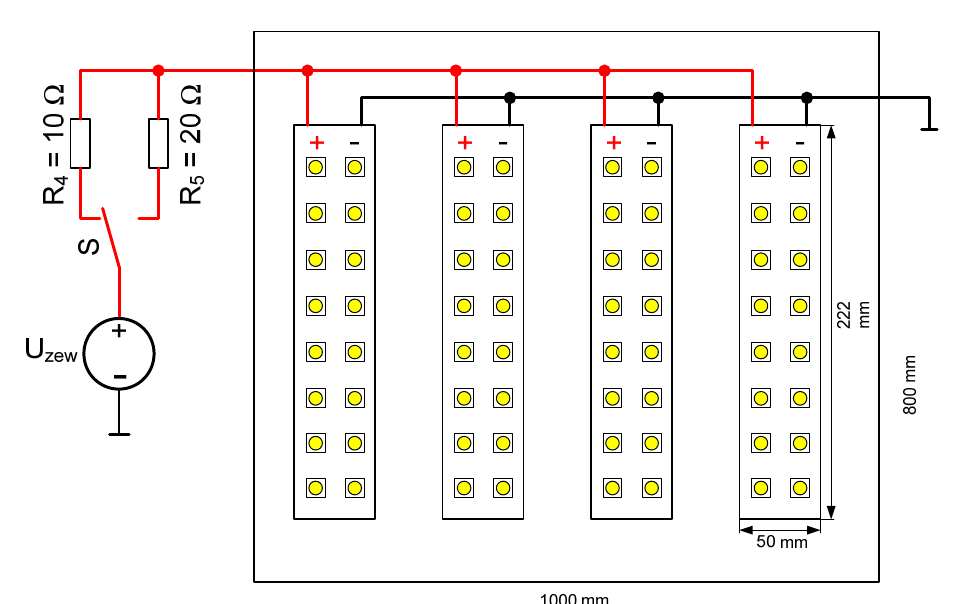
Figure 10. Scheme and dimensions of the ceiling modular lighting source.